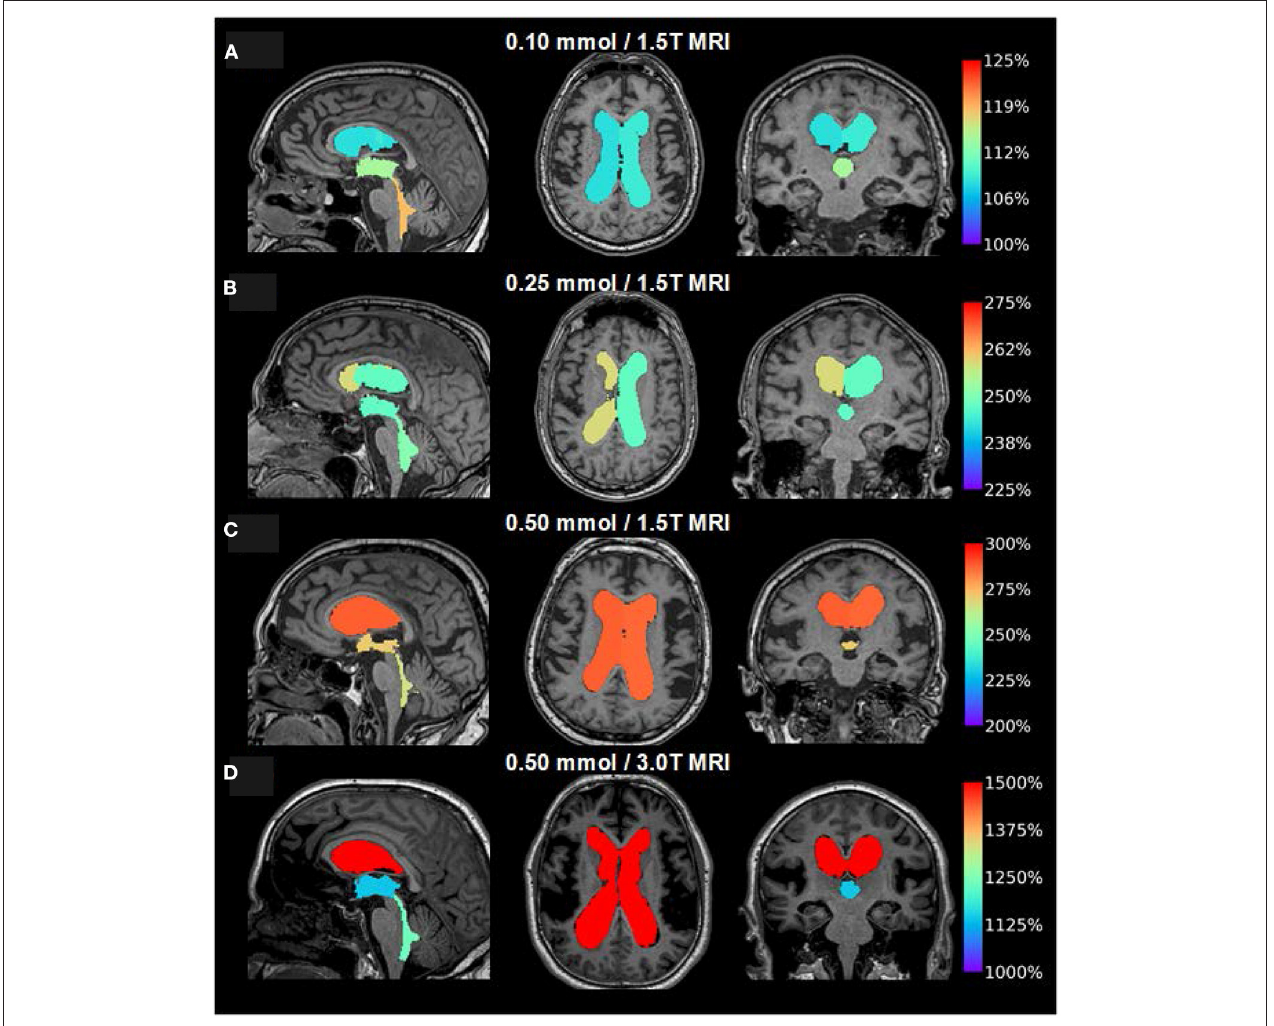
FIGURE 4 | Visualization of dose-dependent tracer enrichment at group level 24h after intrathecal gadobutrol in the doses (A) 0.10 mmol (1.5T MRI; n = 18), (B) 0.25 mmol (1.5T MRI; n = 25), (C) 0.50 mmol (1.5T MRI; n = 19), and (D) 0.50 mmol (3T MRI; n = 33). The percentage change in a normalized T1 signal is indicated on the color bar to the right. It should be noted that the scale bar to the right differs for figures (A–D)